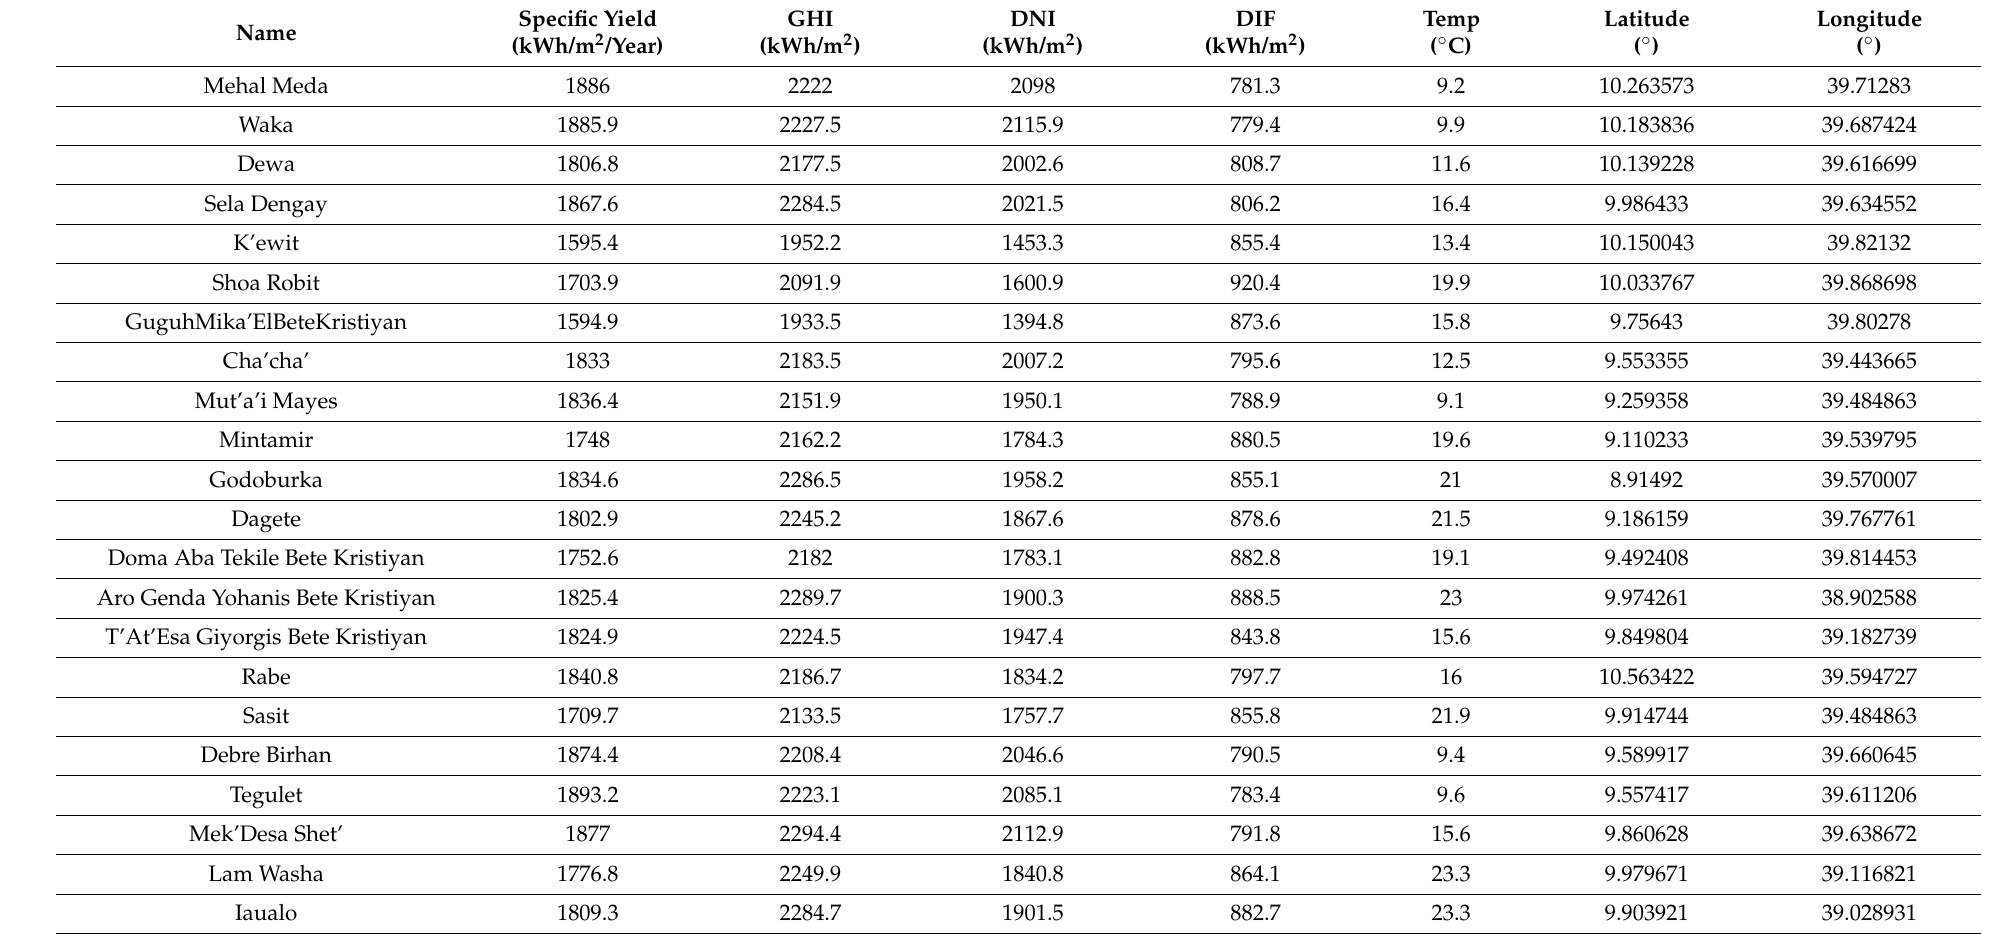
Table 1. Annual average solar radiation assessment of North Shewa at various